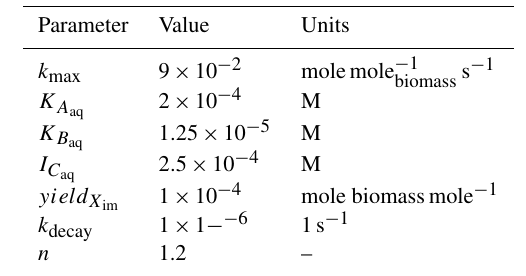
Table 2. Microbially mediated reaction parameters for the batch biodegradation experiment. n only applies to the reaction incorpo- rating the Hill function (i.e., Eq. 15). M signifies molarity or mole per liter of